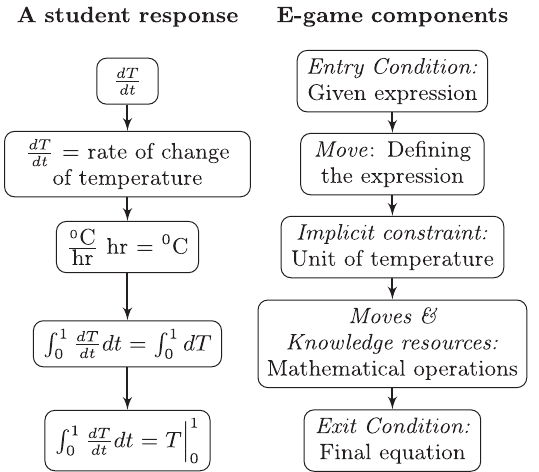
FIG. 5. Example of the analytical derivation epistemic game for solving the temperature